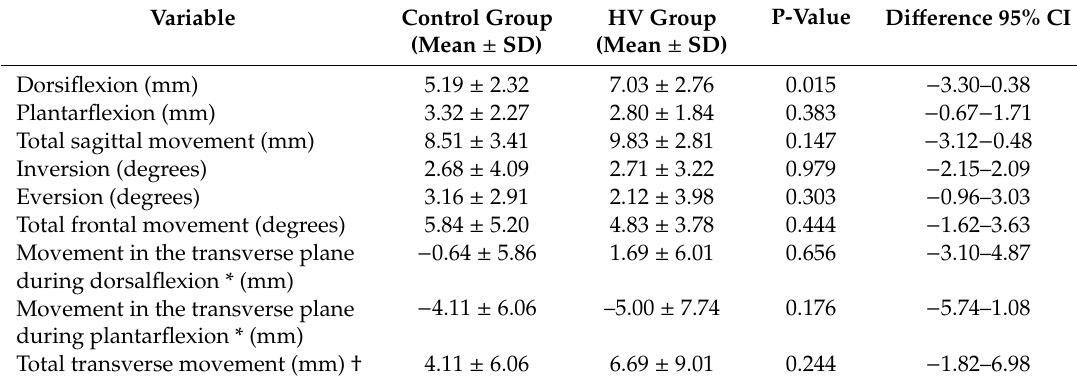
Table 1. Radiographic data of the first ray range of motion in the sagittal, frontal and transverse planes in both groups, and significance ( P -value).